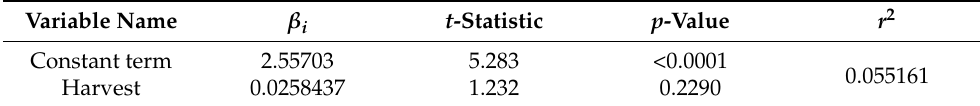
Table 5. Real price of wild mushrooms against